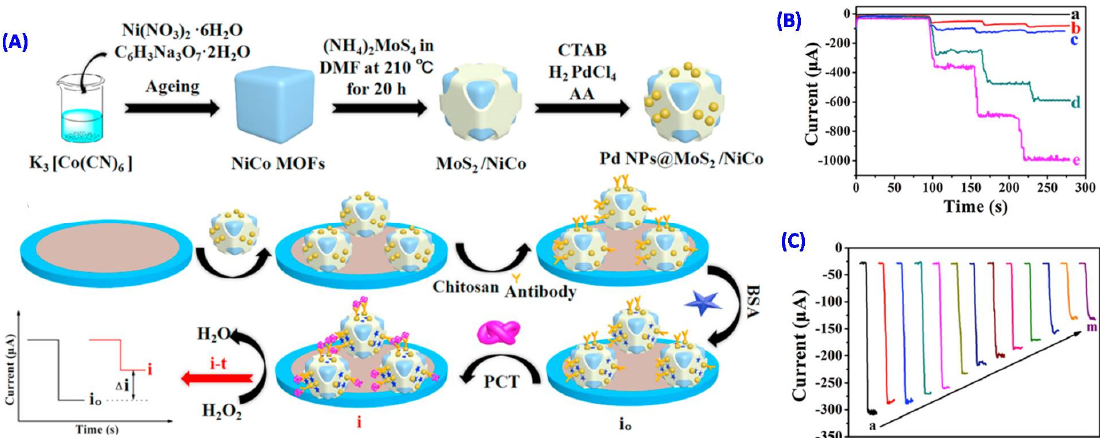
Figure 6. ( A ) Representation of the steps involved in the fabrication of Pd NPs@MoS 2 /NiCo heterostructures and ( B ) Fabrication of the immunosensor, chronoamperometric detection of PCT. ( B ) Chronoamperometric curves obtained for different electrodes at − 0.1 V in PBS of 0.07 mol/L concentration and pH 7.38, for three consecutive additions of 0.015 mol/L H 2 O 2 : (a) NiCo MOFs, (b) MoS 2 /NiCo, (c) Pd NPs@NiCo, (d) Pd NPs@MoS 2 and (e) Pd NPs@MoS 2 /NiCo. ( C ) Chronoamperometric responses recorded for the immunosensor upon addition of different concentrations of PCT (from a to m: 0, 0.0005, 0.001, 0.005, 0.01, 0.05, 0.1, 0.5, 1, 5, 10, 50, 100 ng/mL) in 10 mL PBS (0.07 mol/L, pH 7.38) containing 5.0 mmol/L H 2 O 2 [32].